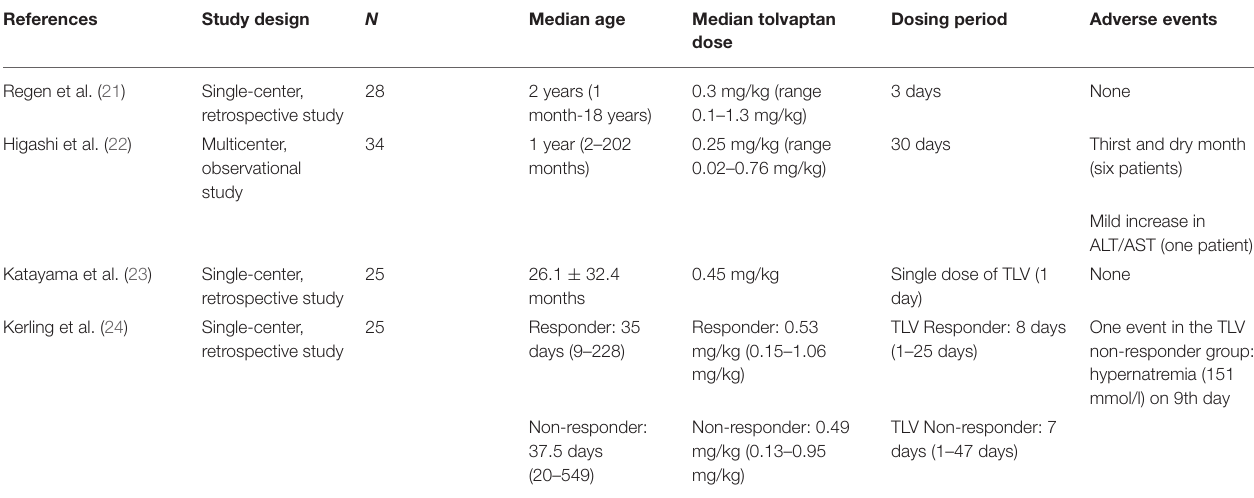
TABLE 2A | Main studies on tolvaptan use in children with hypervolemic hyponatremia.